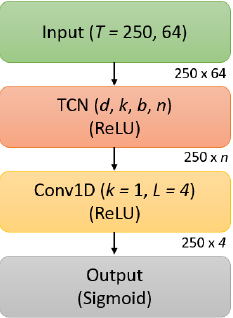
Figure 11. Visual representation of the TCN classifier. Each block corresponds to a layer, with hyper- parameters for that layer italicized , and the activation function in